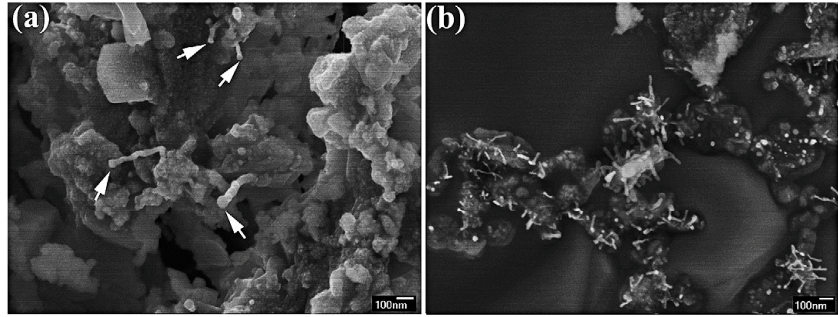
Figure 15. SEM images of ( a ) grown nano-whiskers during annealing treatment at 950 °C, and ( b ) the formation of nano-whiskers on the Al grains, as shown by the white arrows [133]. (Adapted with permission from [133], Elsevier, 2006.)